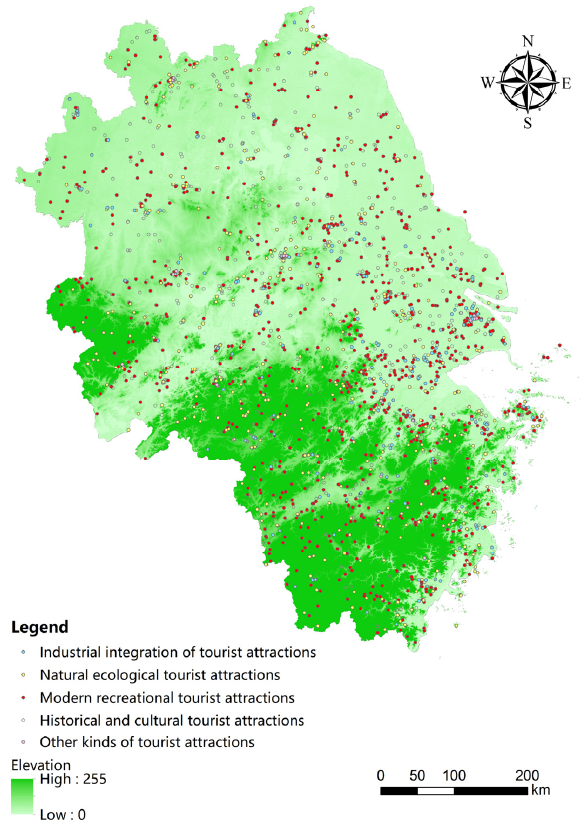
Figure 5. Coupling of topography and the spatial distribution of tourist attractions.